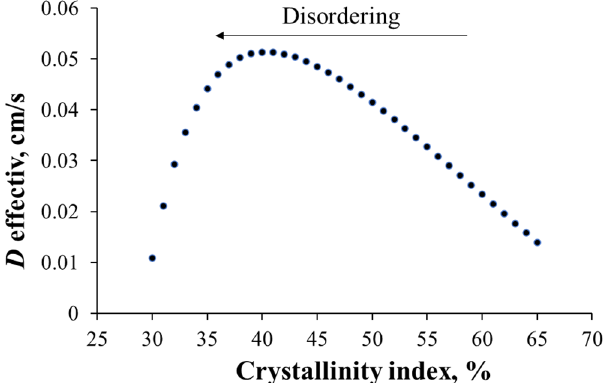
Figure 6. Dependence of the effective mass transfer constant on the crystallinity index for particles of 130 μ m.